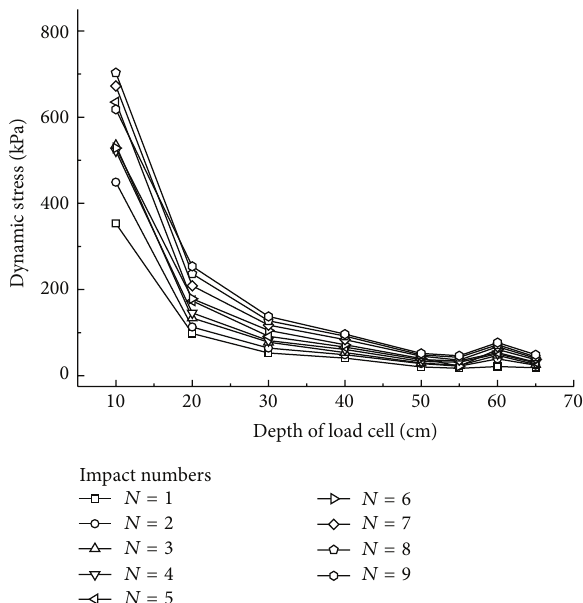
Figure 7: Variation of peak dynamic stress with